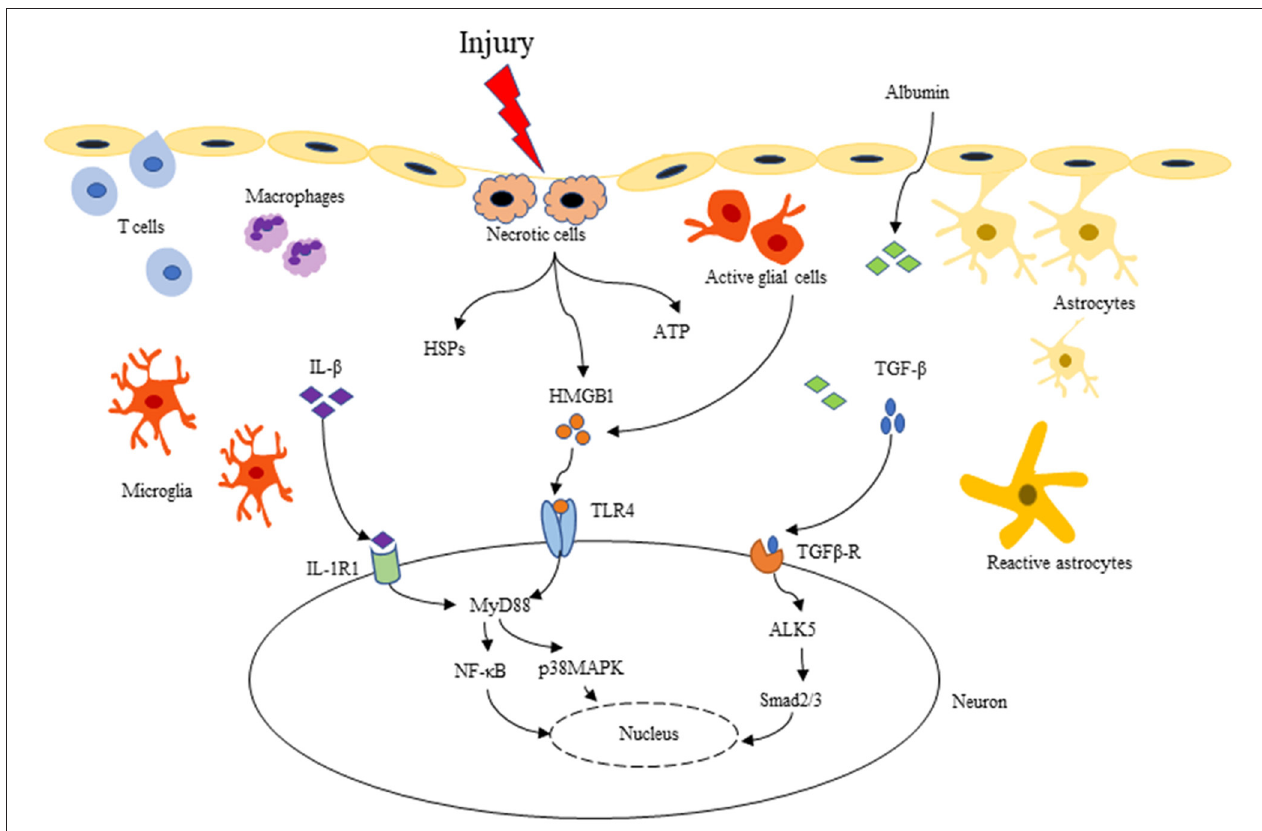
FIGURE 2 | Three key inflammatory signaling pathways related to PTE: IL-1 β /IL-1R, HMGB1/TLR4, and TGF- β /albumin pathway. After TBI, BBB is destroyed, as well as microglia and astrocytes are activated. Pro-inflammatory cytokines such as IL-1 β , HMGB1 and TGF- β are released into the extracellular matrix. IL-1 β binding to IL-1R can activate the downstream NF- κ B, p38 MAPK, Src, etc. and initiate intracellular signal transduction through MyD88-dependent or independent signaling pathways. HMGB1 can be passively released by necrotic cells, or be actively secreted to the extracellular from activated microglia and astrocytes, binding to many different types of cell receptors (TLR2/4, RAGE), and activating downstream signaling molecules like the IL-1 β /IL-1R signaling pathway. In addition, TBI causes BBB destruction, serum albumin extravasates into the extracellular matrix, activating the TGF- β /ALK5 pathway. These series of inflammatory cascades can lead to increased excitability and synaptic reconstruction, which in turn promotes the development of